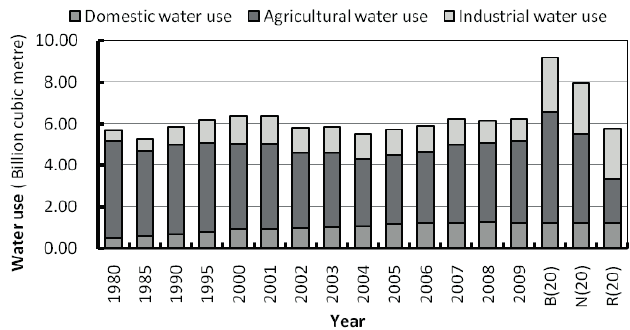
Fig. 1 Water use change in the Weihe River Basin.